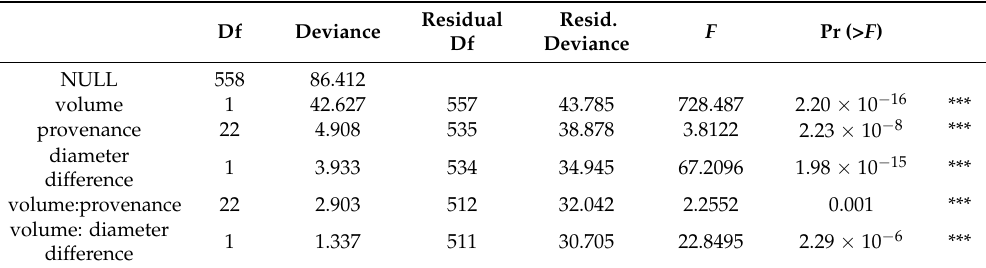
Table 4. Resulting simplified gamma model of defoliation.